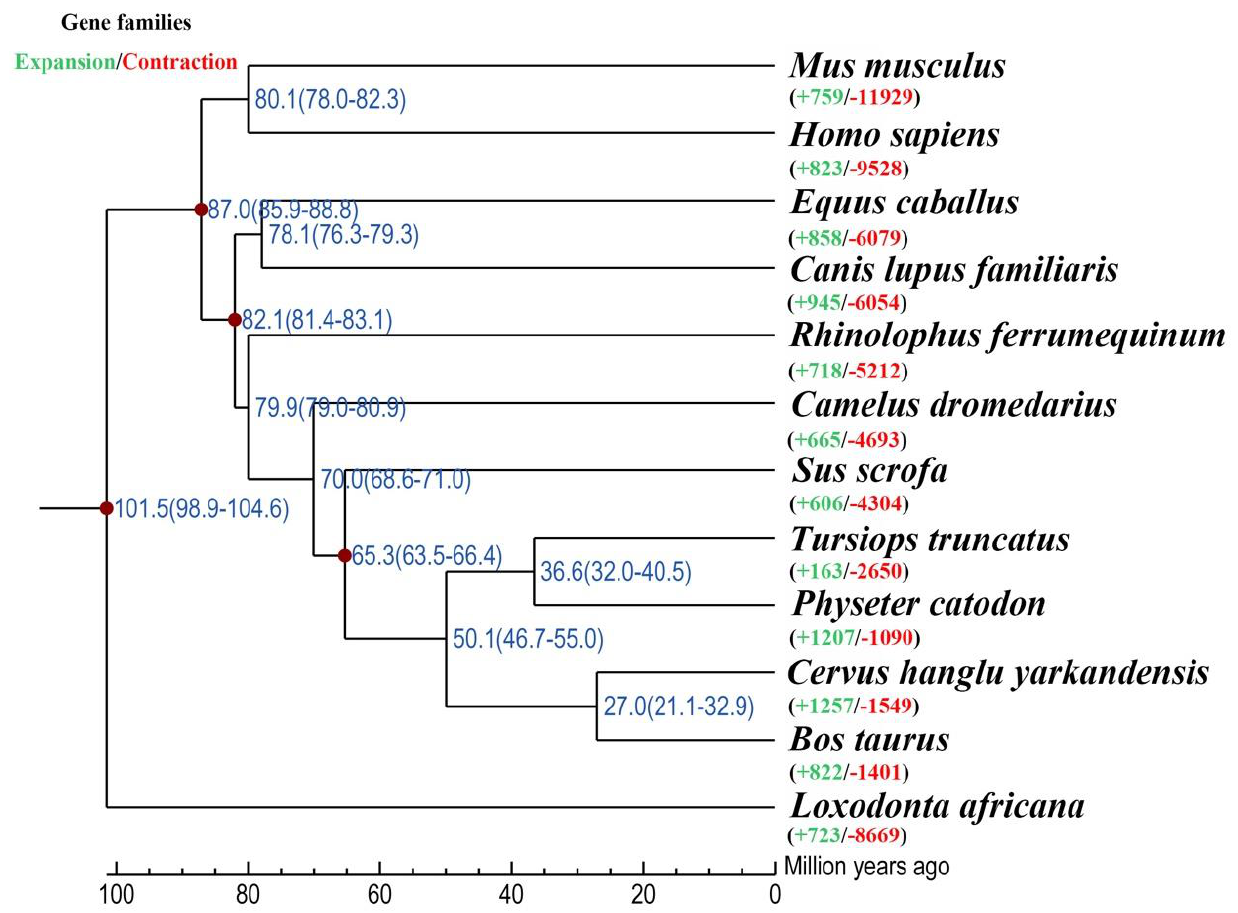
Figure 1. Phylogenetic tree constructed using one-to-one orthologous gene of the 12 mammalian species studied.